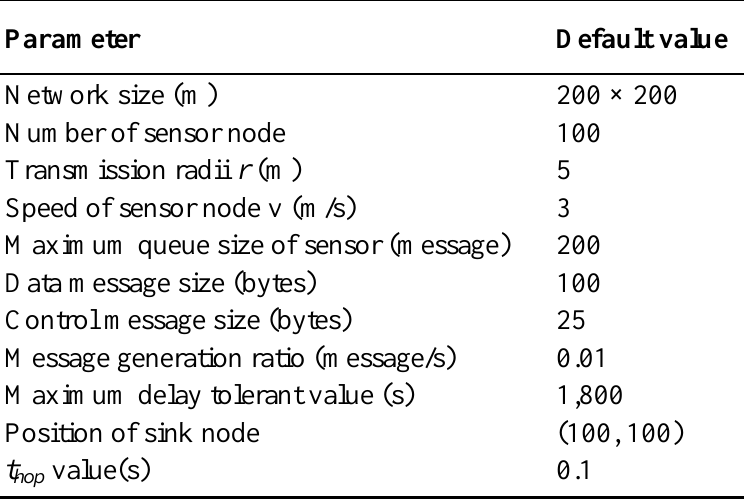
Table 1. Simulation